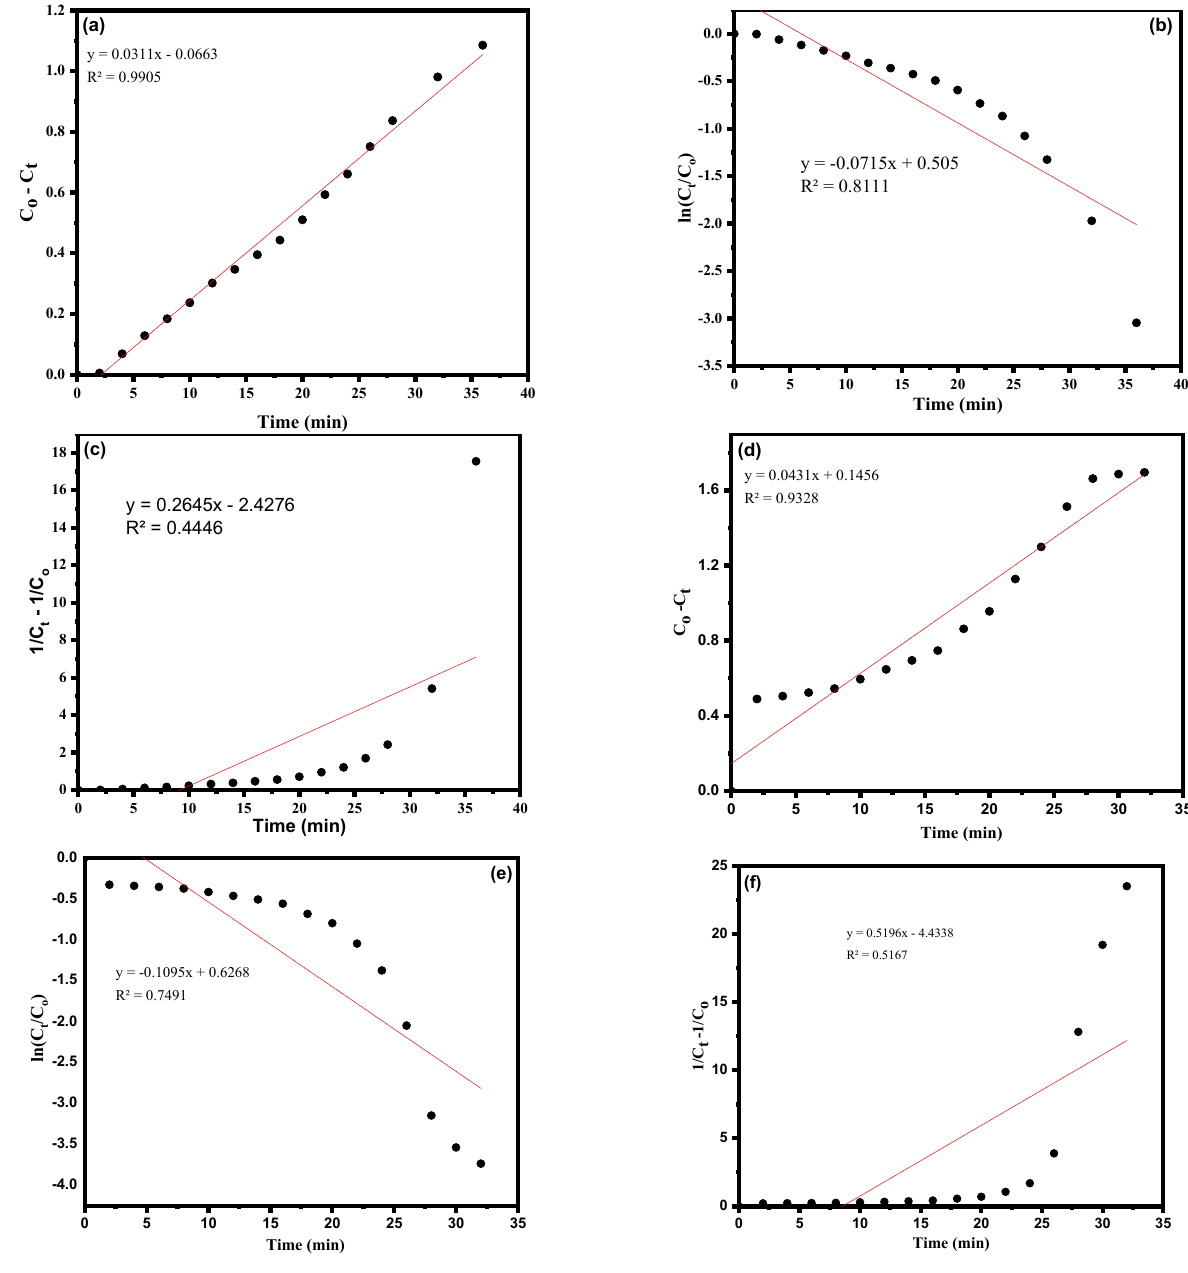
Figure 11. Chemical kinetic linear equation model after using CA-AgNPs and NaBH 4 ; For CR degradation kinetic, zero-order ( a ), first-order ( b ), second-order ( c ); For MB degradation at zero-order ( d ), first-order ( e ) and second-order ( f ).